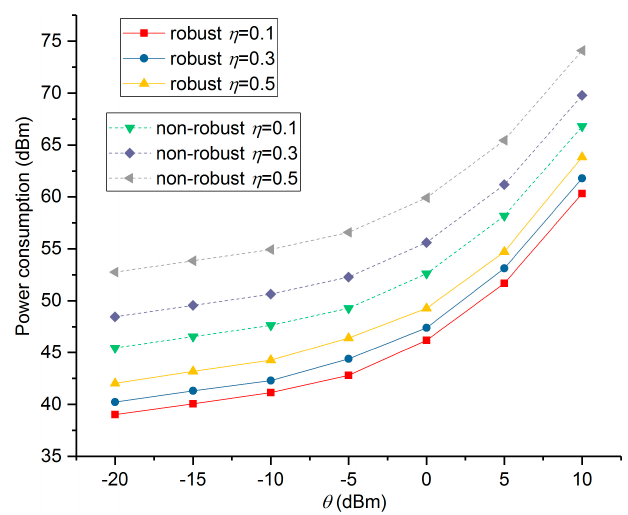
Figure 4. Power consumption versus EH threshold with different channel estimation error thresholds.